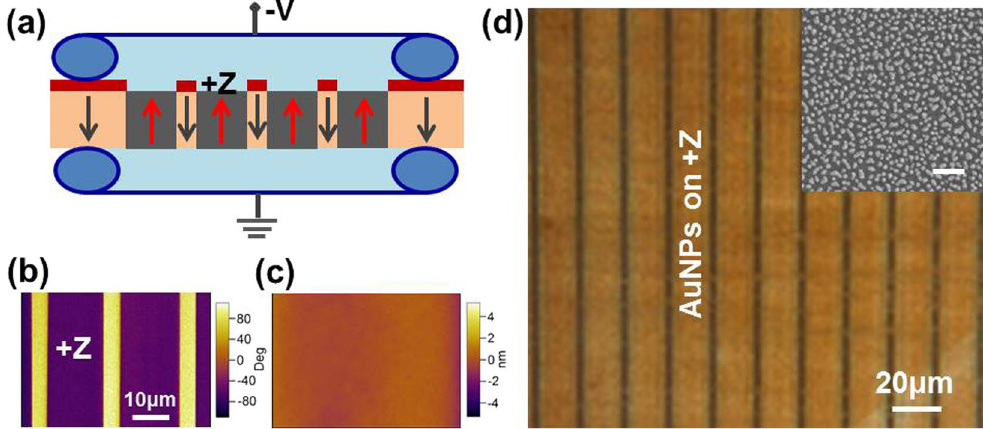
Figure 1. ( a ) Schematic of electric poling for fabrication of the PPLN. Photoresist (red blocks) with a periodical pattern was formed on the surface of negatively-poled LiNbO 3 single crystal. An external negative voltage ( > 21 kV/mm, coercive field of the LiNbO 3 ) was applied through a liquid electrode (light blue areas) to invert polarizations from negatively-poled ones (gray arrows) into positively-poled ones (red arrows). PFM phase ( b ) and topographic images ( c ) taken from the same area. ( d ) Dark field image of AuNPs array with AuNPs assembled onto + Z surfaces of the PPLN template. The insert is a representative SEM image showing morphology of AuNPs ca. 35 nm in average diameter. The scale bar in the insert is 200